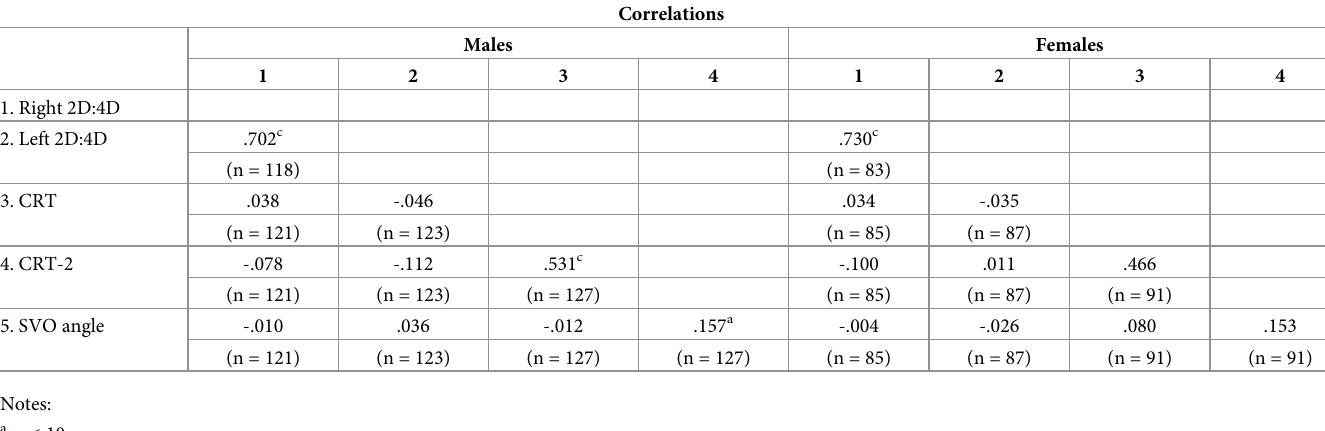
Table 2. Correlations between right 2D:4D, left 2D:4D, CRT, CRT-2, and SVO angle in men and women.